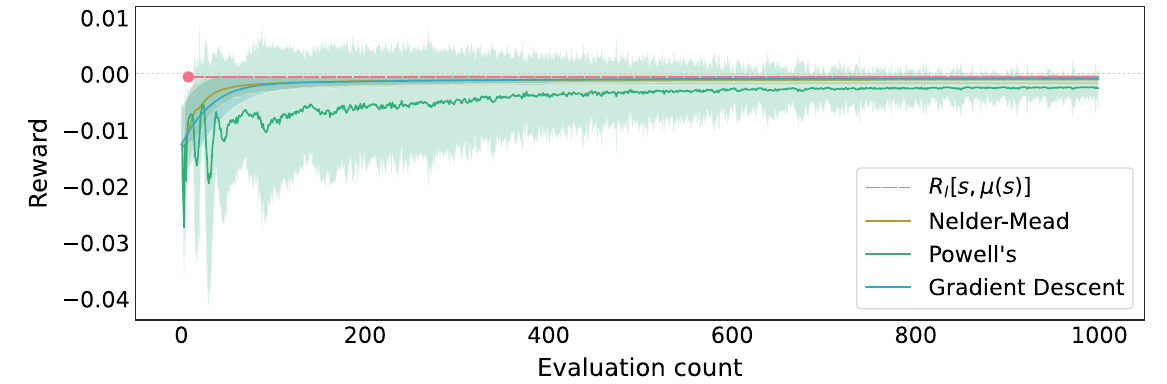
FIG. 7. Comparison of the evaluated RL policy μ ð s Þ with local optimization algorithms with respect to achieved reward at different evaluation counts. A larger reward is better. We show the mean of 800 repetitions over 1000 evaluation steps. The standard deviation is plotted semitransparent. The RL policy is plotted as a dashed line to highlight that it is only a fixed value since, after completing training, it only requires one evaluation of the reward